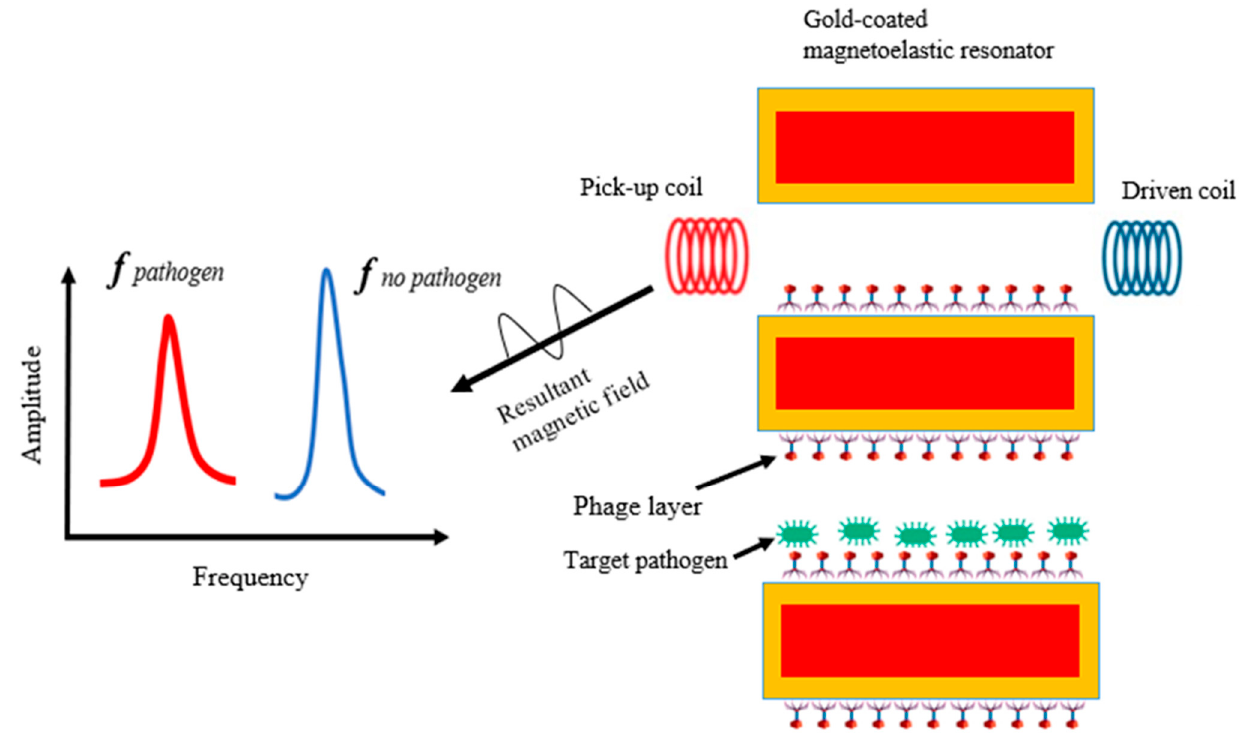
Figure 6. Schematic diagram elucidating the detection principle of the magnetoelastic phage sensor platform. Table 3. Phage-based quartz crystal microbalance (QCM) and magnetoelastic (ME) biosensors.